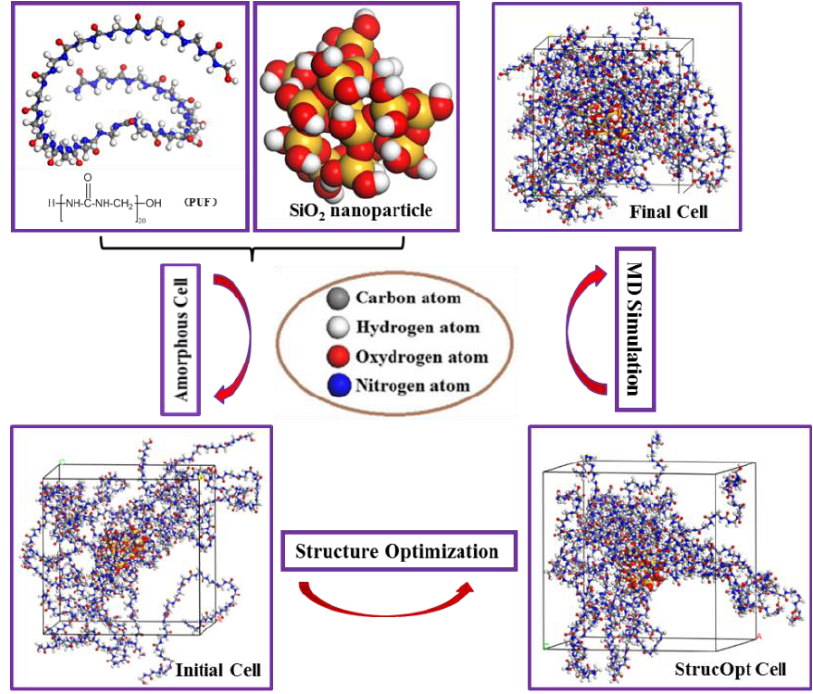
Figure 5. The entire calculation process of the PUF-SiO 2 model. Here, the MD simulation contains three steps: NVT-MD simulation (T=298 K, 100 ps); NPT-MD simulation (P= 1 bar, T=298 K, ＞ 1500 ps); NVT-MD simulation (T=298 K, 500 ps).